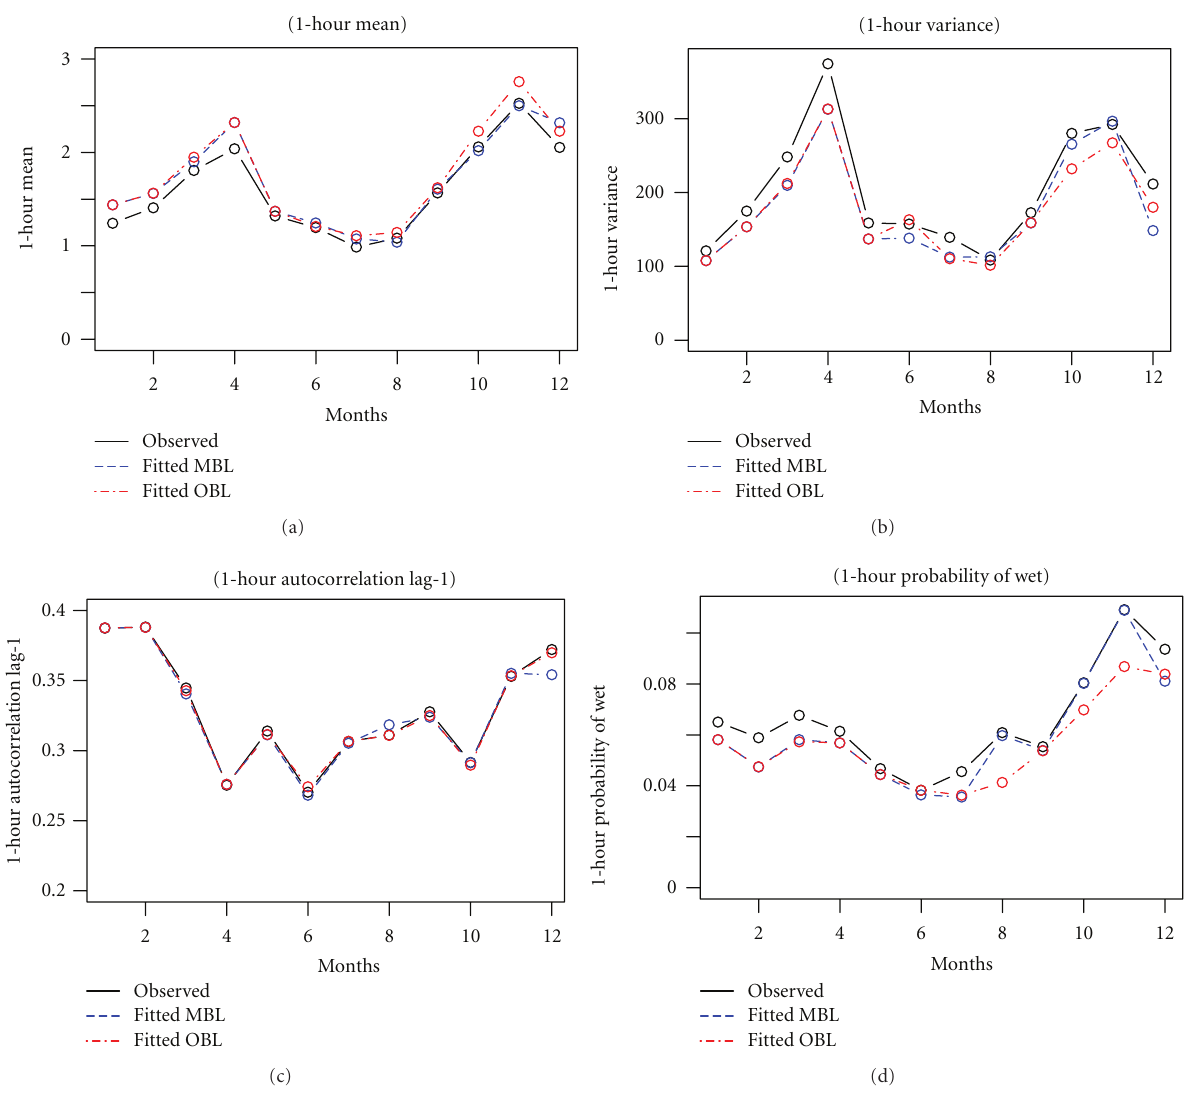
Figure 3: Observed and fitted properties for the original and modified models.